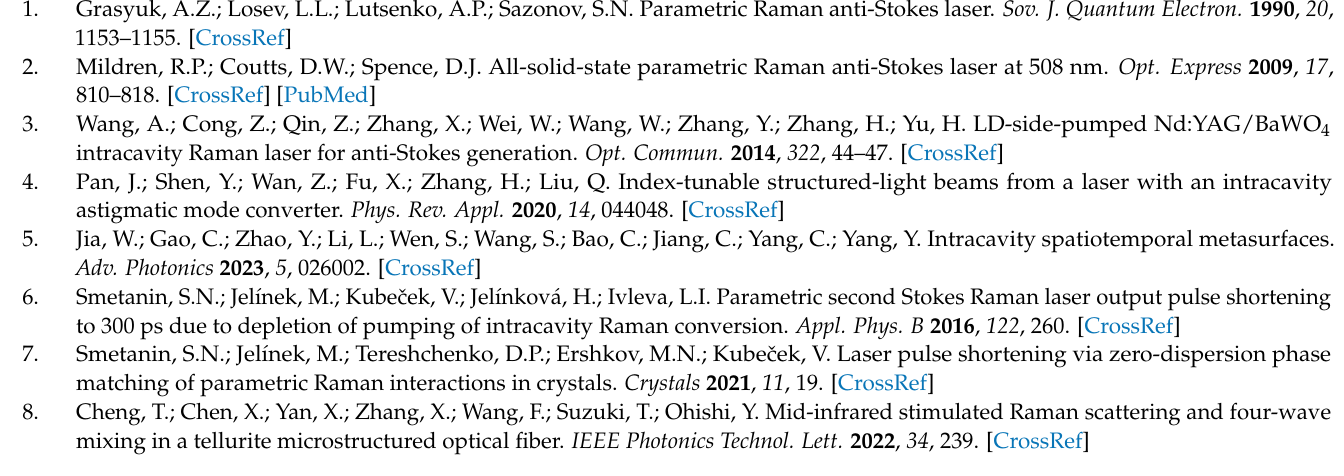
12 of 14 Figure 8. The simulation results of the mode ‐ locked laser oscillation for the shutter with t open = 2 ns at ( a ) φ = 17°, ( b ) φ = 27°, and ( c ) φ = 37°. It can be seen from Figure 8 that the use of the rapidly acting shutter led to the gen ‐ eration of an intense ultrashort pulse train of the pump laser radiation (green line), which is similar in result to the mode ‐ locking regime. Despite the small value of r a / r b , we can also see the efficient SRS oscillation of a train of ultrashort Stokes pulses (red line), which ensures the generation of a single intense ultrashort anti ‐ Stokes pulse (blue line). The ra ‐ diation pulses turned out to be significantly shorter and more intense than in the previous case. However, it should be noted that we used a single ‐ mode model, so the duration